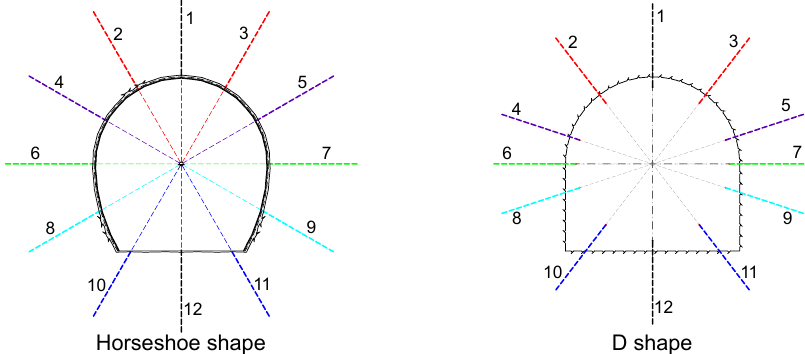
Figure 9. Tunnel sections were modified from a horseshoe shape to